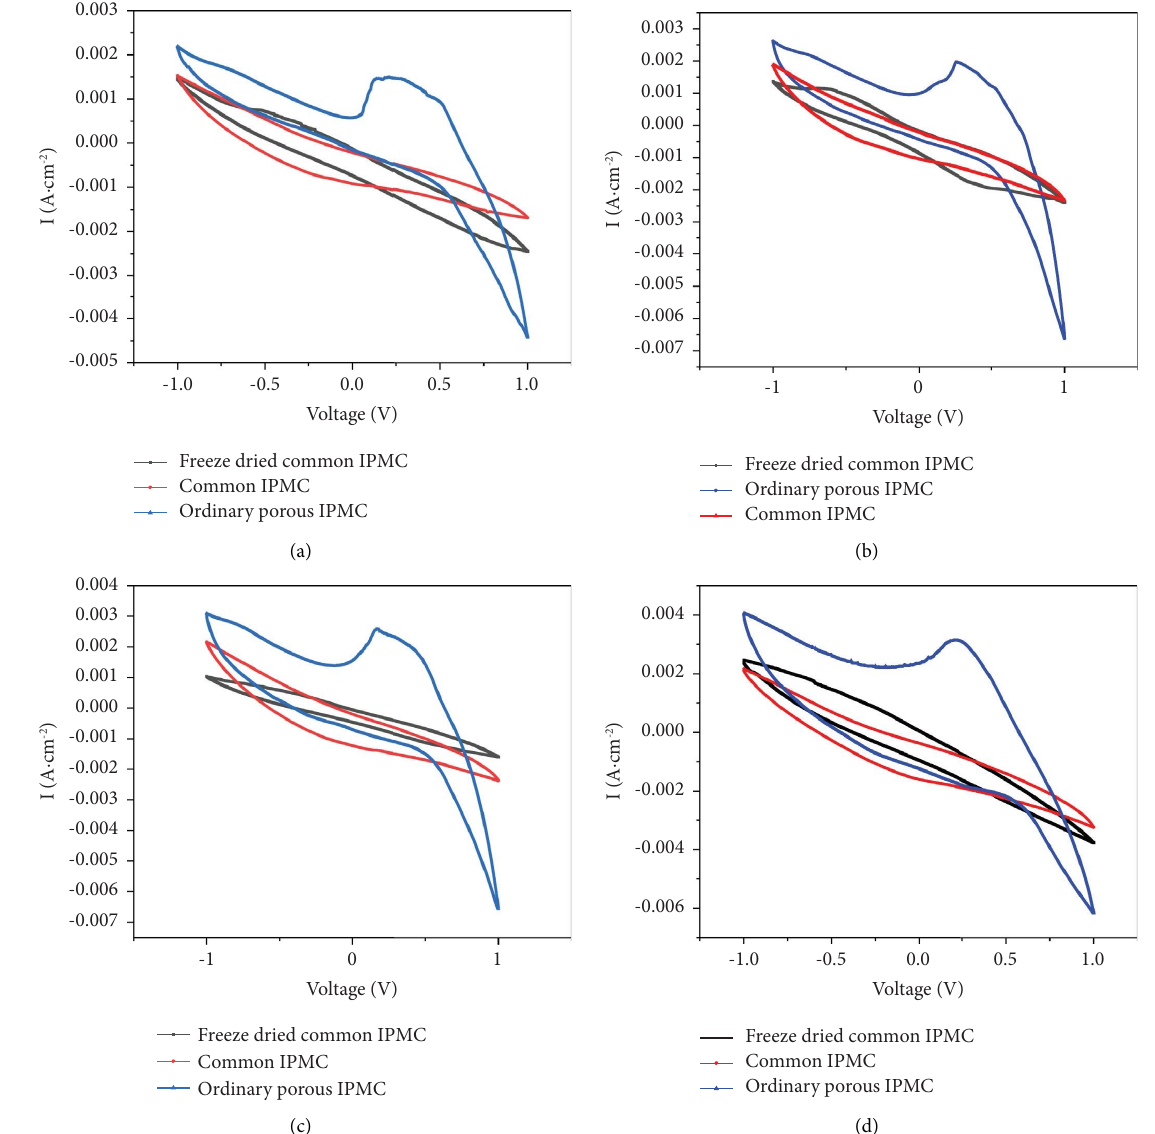
Figure 6: Te scanning range of IPMC without carbon nanotubes is − 1V–1 V CV: (a) 50mV/s; (b) 100mV/s; (c) 200mV/s; (d)